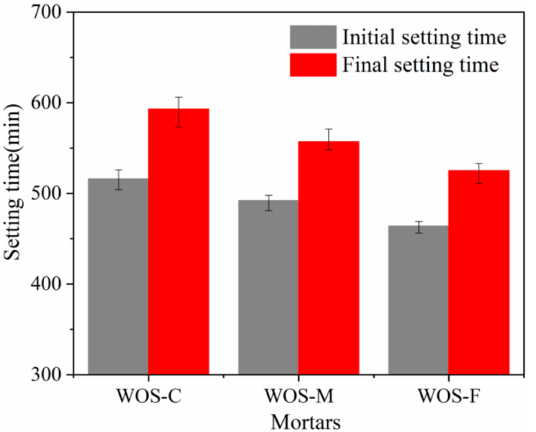
Figure 5. The effect of particle size of WOS on the setting time.